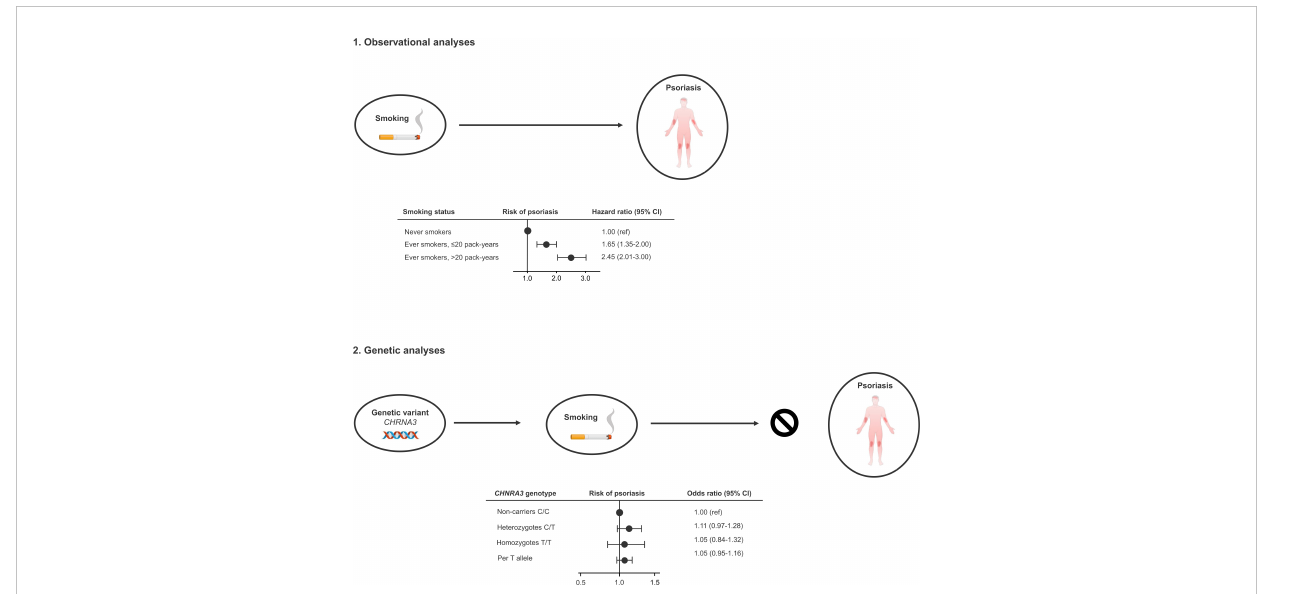
FIGURE 4 Take-home fi gure. Observationally, ever smokers (former and current smokers) have increased risk of developing moderate to severe psoriasis (1). However, using the genetic variant CHRNA3 rs1051730 as a robust proxy for lifelong high cumulative smoking, we do not fi nd an increased risk of moderate to severe psoriasis, indicating that smoking is an observational but not causal risk factors for moderate to severe psoriasis